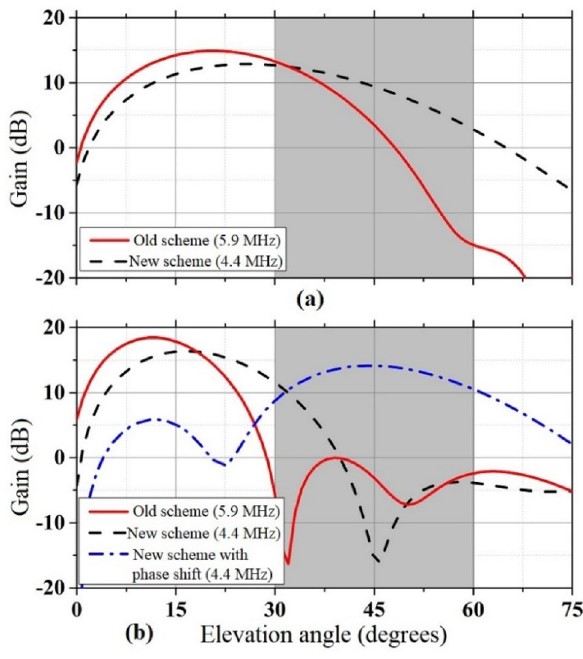
Figure 17. Comparison between the radiation patterns in the vertical plane for the new and old schemes: ( a ) HR 2/2 mode and ( b ) HR 4/4